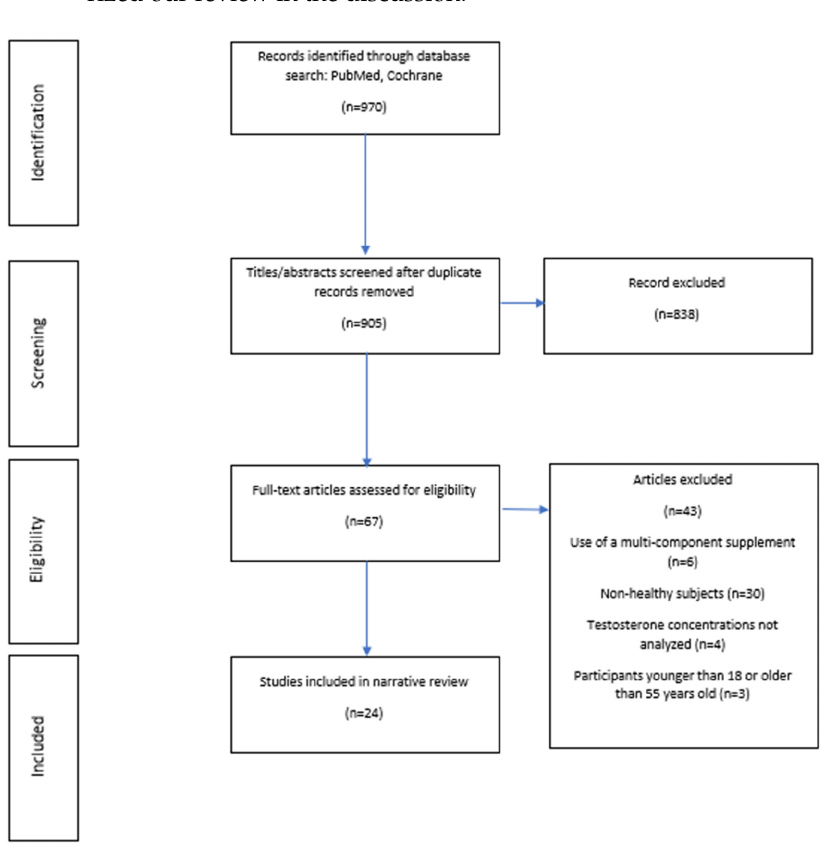
Figure 1. Study selection process.